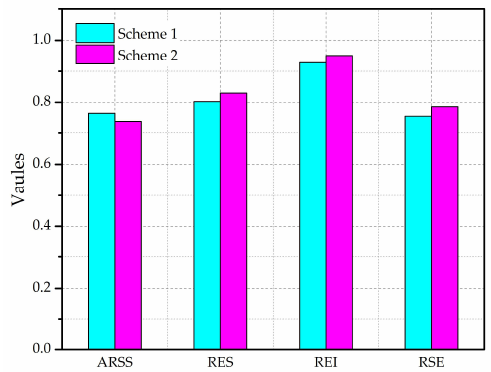
Figure 8. Restoration efficiency and economic assessment results.